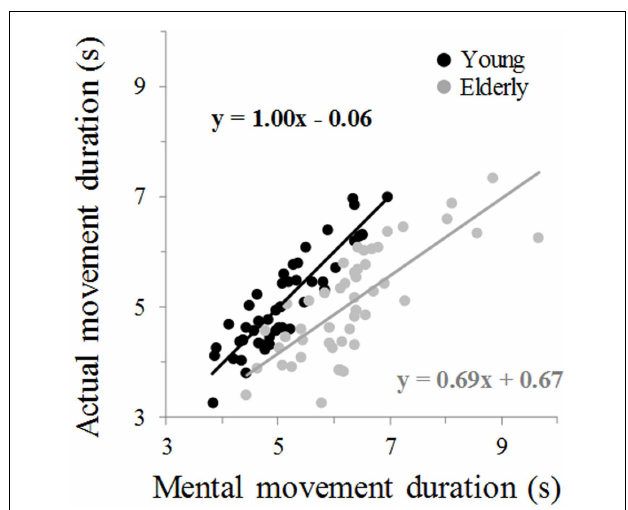
FIGURE 3 |Average mental movement duration is plotted versus the average movement duration .The total number of marks for each group is 48 (24 participants × 2 arms). Each mark is the average value of 10 actual and 10 mental trials from one participant.The equation of the linear regression analysis is also depicted for each group.